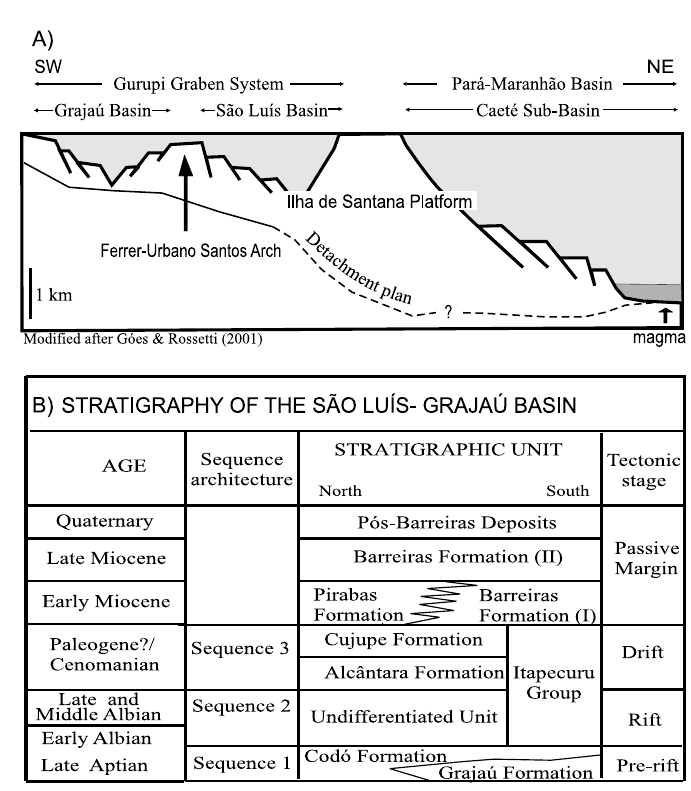
Fig. 2–A)DiagramwiththesketchedrepresentationoftheproposedstructuralpatternoftheSãoLuís-GrajaúBasinintheGurupiGraben System, and its relation with the Pará-Maranhão Basin. In this model, the Ferrer-Urbano Santos Arch is considered as an intrabasin horst within an abandoned intracontinental rift system formed by combination of pure shear stress and strike-slip deformation. The northeastward rifting migration through time gave rise to the development of a deeper basin, represented by the Caeté Sub-basin